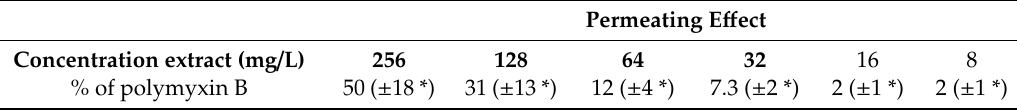
Table 5. E ff ect of A. senegal hydroethanolic extract on bacterial outer membrane of K. aerogenes 289 expressed as percentage of polymyxin B